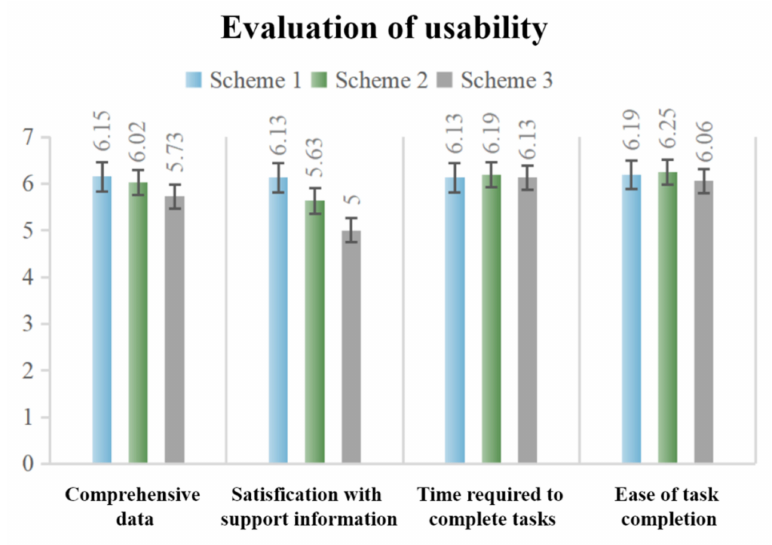
Figure 9. Usability Assessment